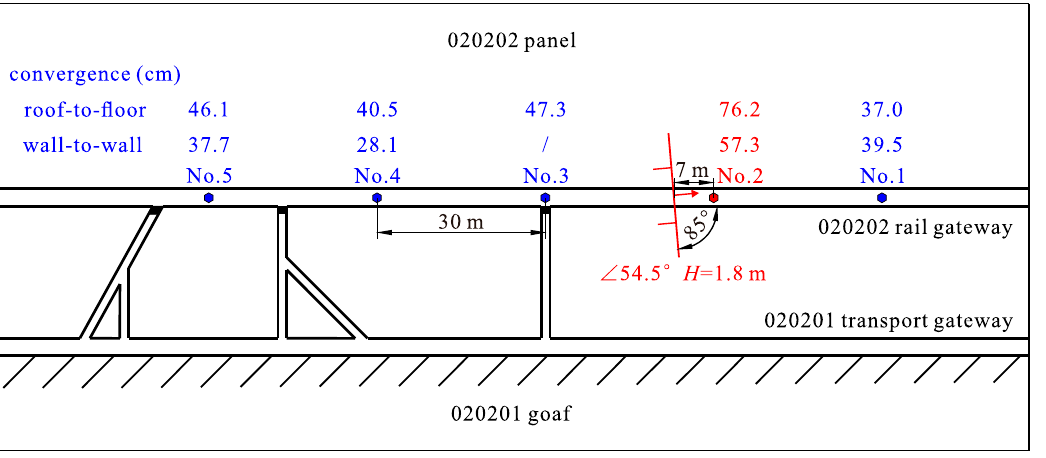
Figure 12. Displacements of the 020202 rail gateway 60 d after excavation.